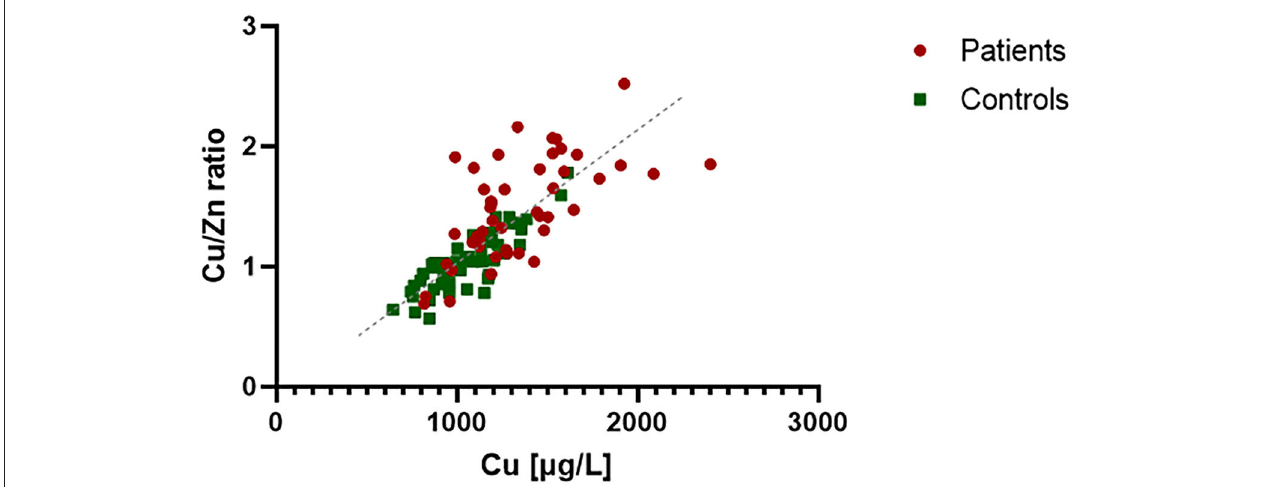
FIGURE 2 | Correlation analysis between Cu and Cu/Zn ratio in plasma of PTC patients and healthy controls. The control group expressed a strong correlation ( R ² = 0.85), which reflect Zn regulation in the body (x/y = Zn). Zn concentration in PTC plasma seems to be less regulated and variable compared to controls ( R ² = 0.39).